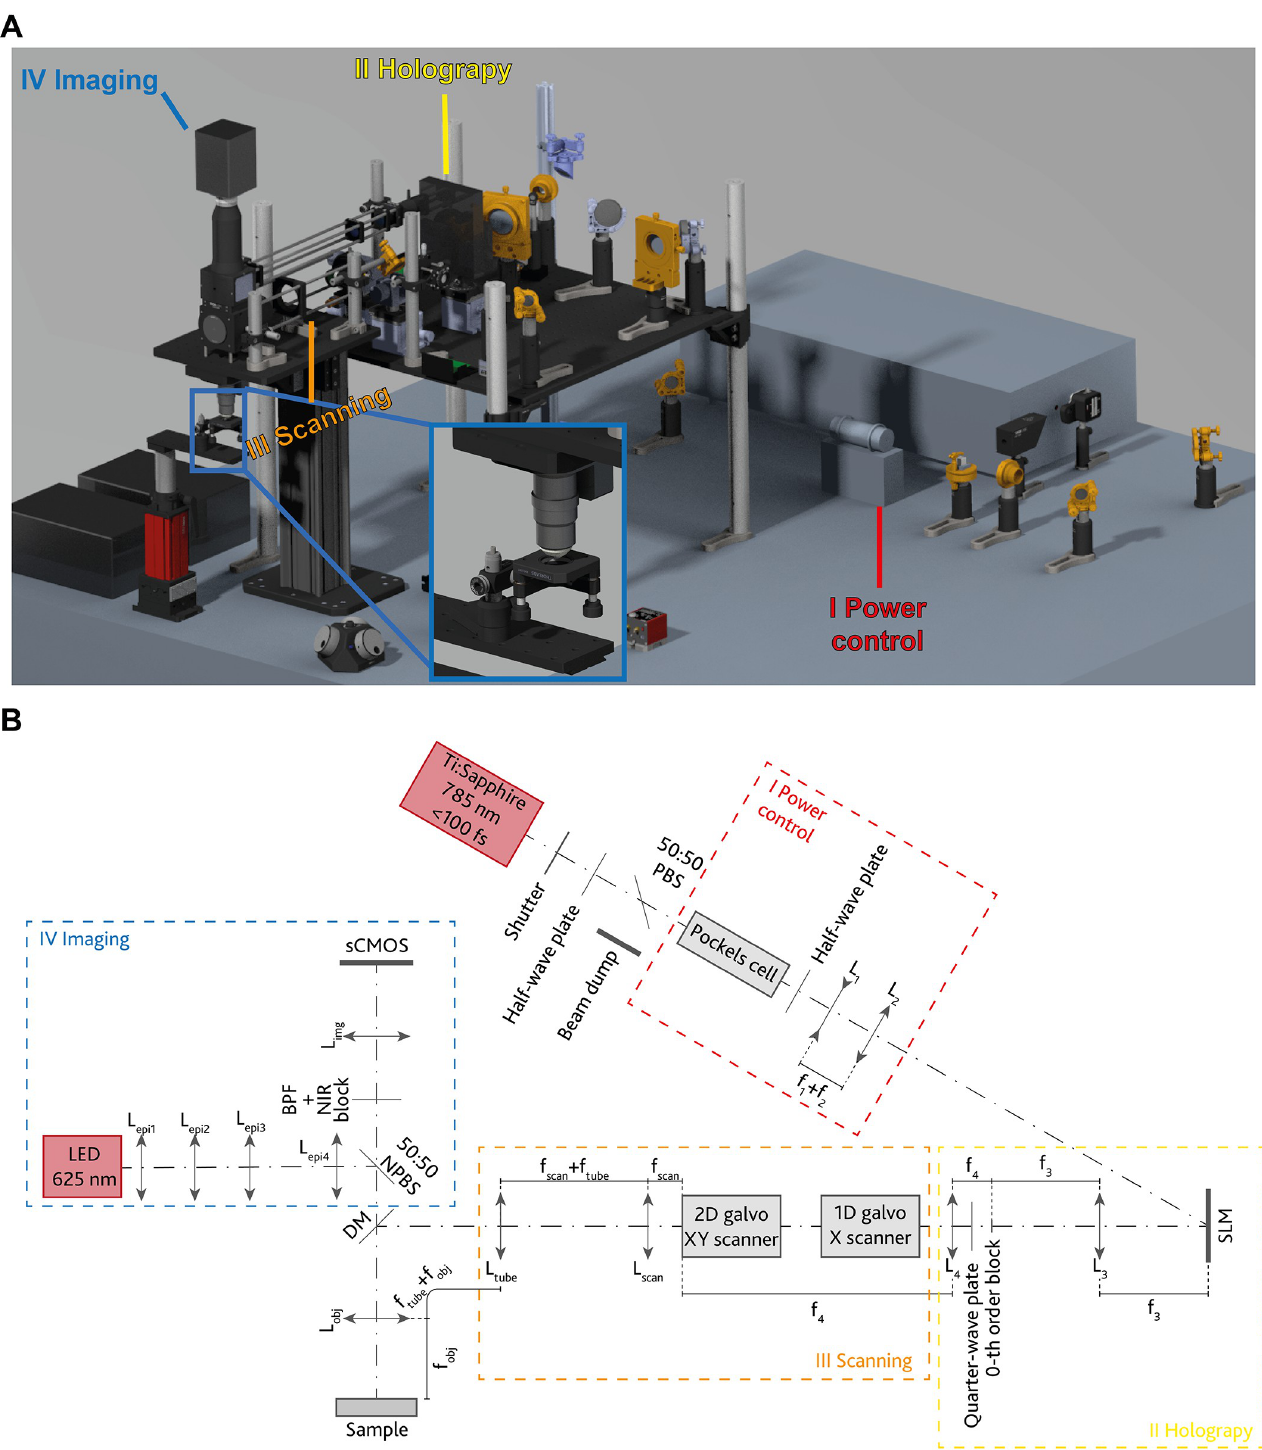
Fig 1. Optical scheme of the system. (A) Overall view from the Computer-Aided Design (CAD) model. The inset shows a magnification of the sample holder and the objective lens. (B) Schematic representation of the system. After power control (I), a fs-pulsed laser beam is phase modulated by the SLM (II) and the reconstructed hologram can be translated within the field of view through a virtually conjugated galvo triplet (III). An epi-illumination and imaging system (IV) allow for real time monitor of the lithographic process. Details on all the optical and optomechanical elements are given in S2 File.